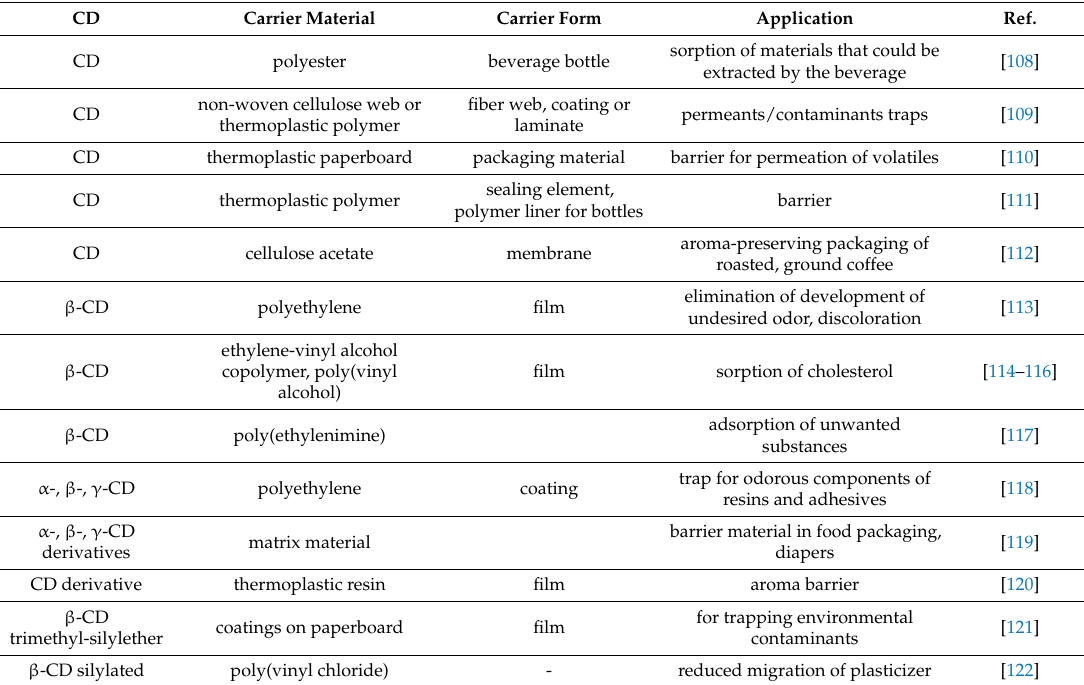
Table 2. Examples of using “empty” CD in packaging